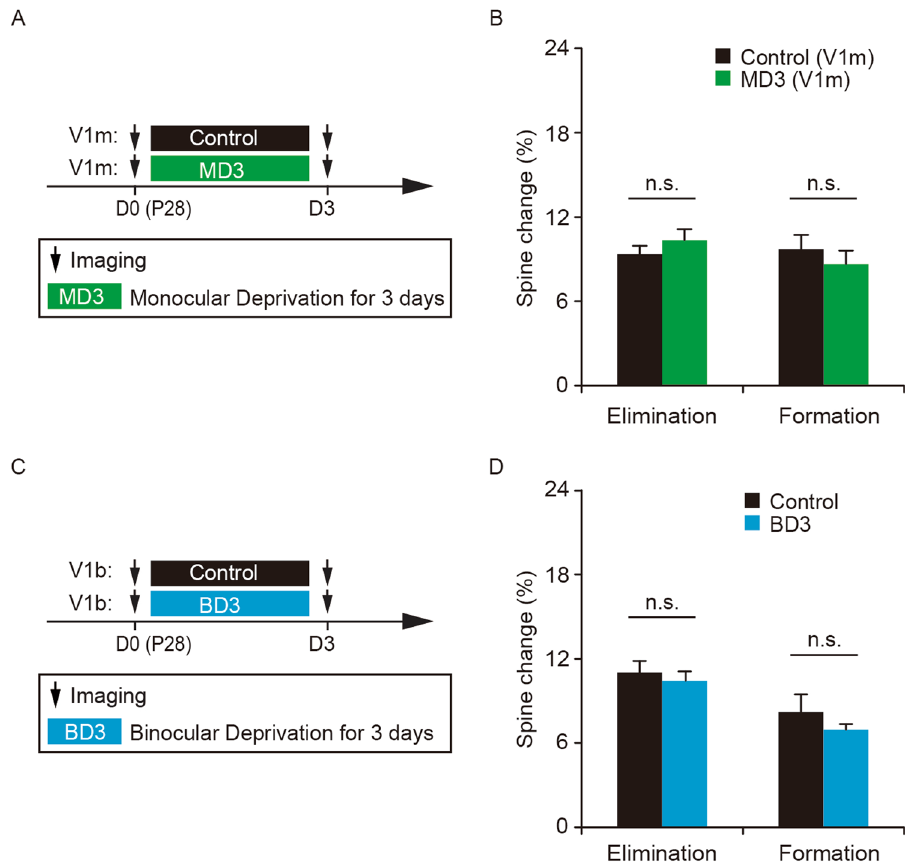
Figure 2. MD-induced spine elimination depends on the competitive interactions between the deprived and non-deprived eye. ( A ) Schematic of experimental design to examine the effect of MD in the monocular region of the primary visual cortex. ( B ) No significant difference in spine elimination or formation over 3 days between MD mice and non-deprived control mice (n = 713 spines, 30 dendrites from 4 MD mice, n = 653 spines, 30 dendrites from 4 control mice). ( C ) Schematic of experimental design to examine the effect of BD in the binocular region of the primary visual cortex. BD represents binocular deprivation. ( D ) No significant difference in spine elimination or formation over 3 days between BD and non-deprived control mice (n = 1023 spines, 47 dendrites from 6 BD mice, n = 1096 spines, 42 dendrites from 6 control mice). Data are presented as mean ± SEM. n.s. = not